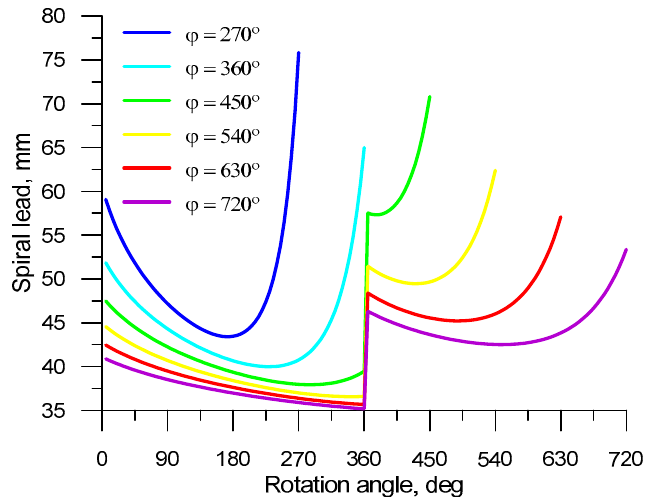
Figure 7. Helix pitch versus rotation angle ϕ in the forming zone (in helical rolling of 40 mm diameter balls). Table 1. Effect of the rotation angle ϕ in the forming zone on the tool length (according to Figure 8) in the numerical analysis.